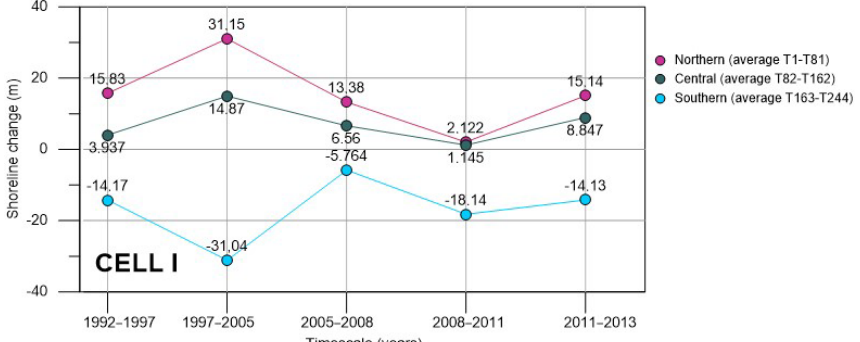
Figure 7. Average shoreline position in northern, central and southern sectors of Cell